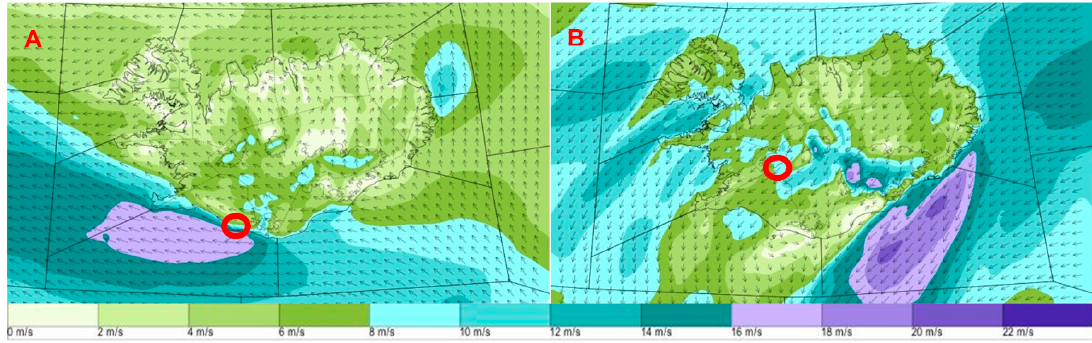
Figure 3. Numerical simulations of 10 m winds (m·s − 1 ) over Iceland at 15 UTC on ( A ) Storm 1 on 15 June 2015 and ( B ) Storm 2 on 4 August 2015. The locations of the dust sources are indicated with a circle.